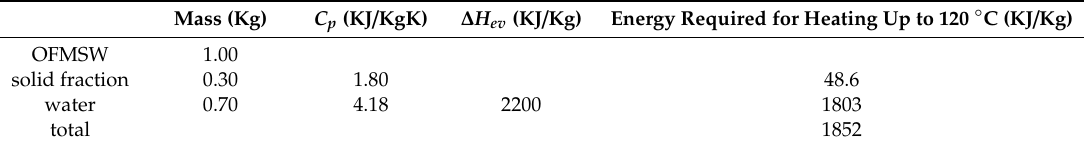
Table 5. Cost estimation for the sterilization of the OFMSW blends.